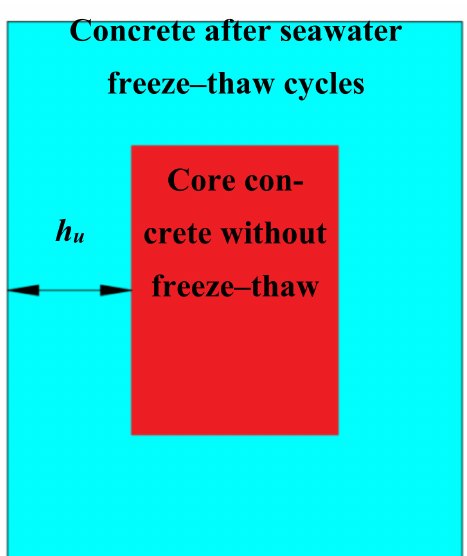
Figure 26. Hierarchical method.